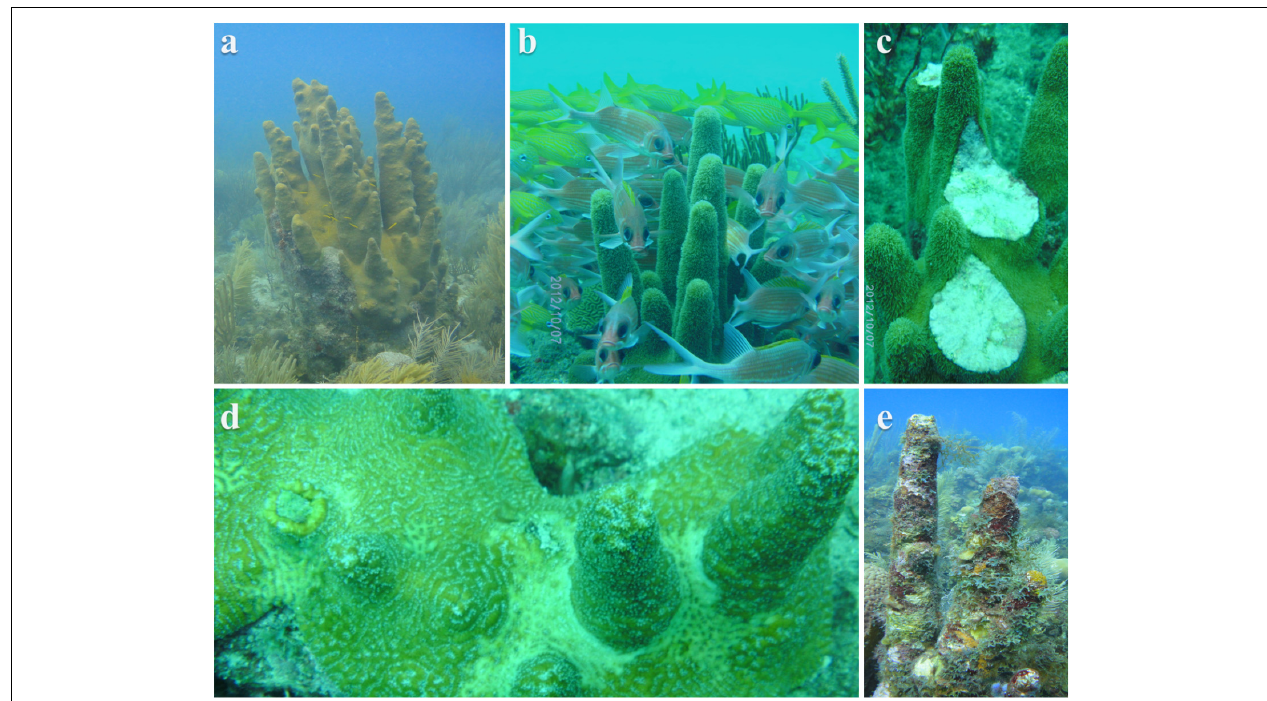
FIGURE 6 | Colonies of D. cylindrus in different condition including: (a) healthy, (b) healthy with associated fauna, (c) fragmented due to anchors breakage, (d) with tissue mortality at the base likely to lead to fragmentation, and (e) dead and colonized by macroalgae and